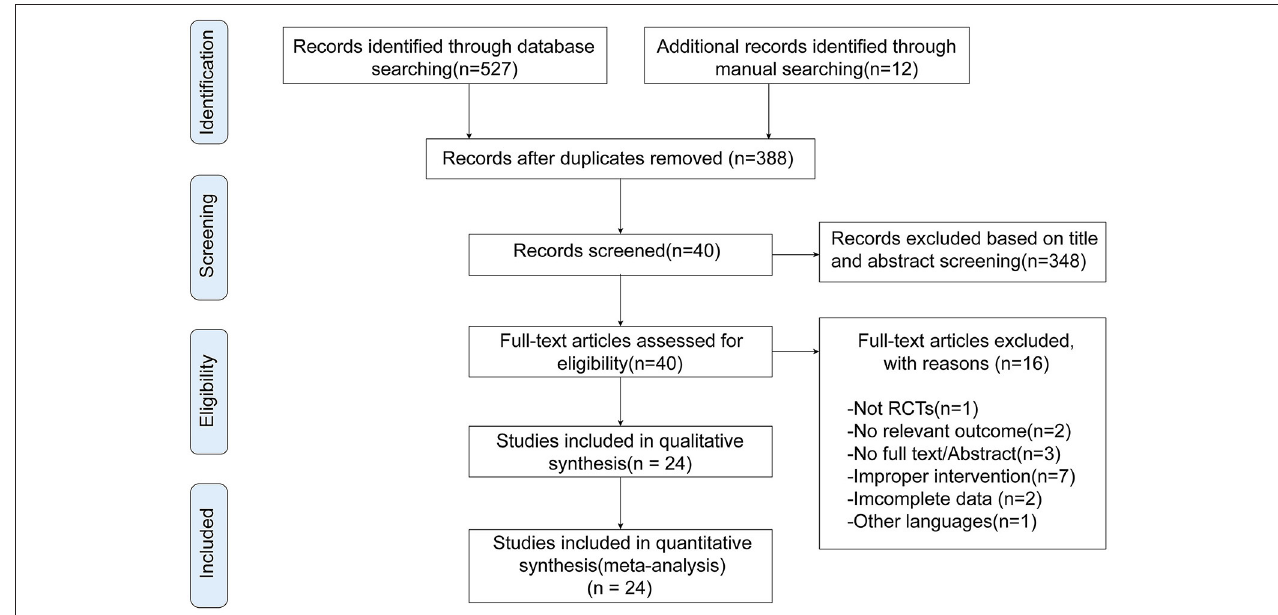
FIGURE 1 | Flowchart of study